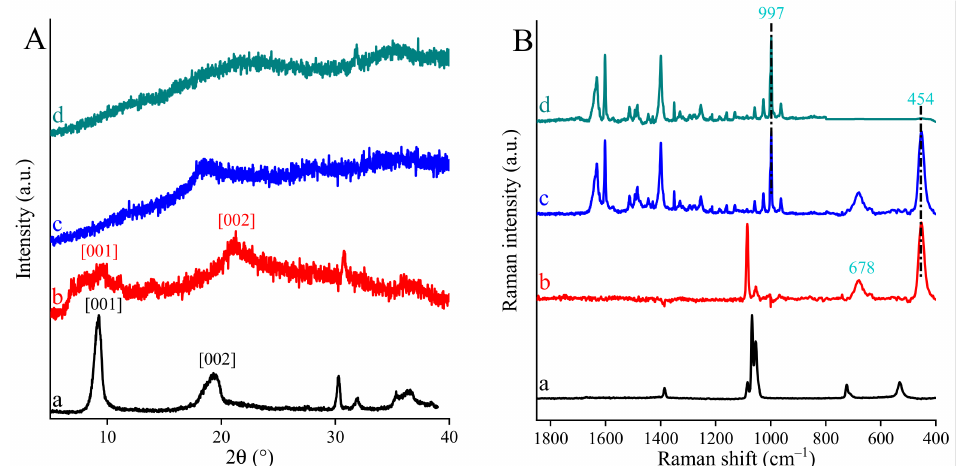
Figure 3. XRD patterns ( A ) and Raman ( B ) spectra of CaAl–cysteinate–LDH (a) and CaAl–cysteinate– LDH oxidized by peracetic acid; reaction conditions: the oxidizing agent in 0.4 M (b), 0.55 M (c) or 0.70 M (d) concentration was applied to 0.1 g of composite suspended in 100 cm 3 of water at 298 K. The reaction time was 60